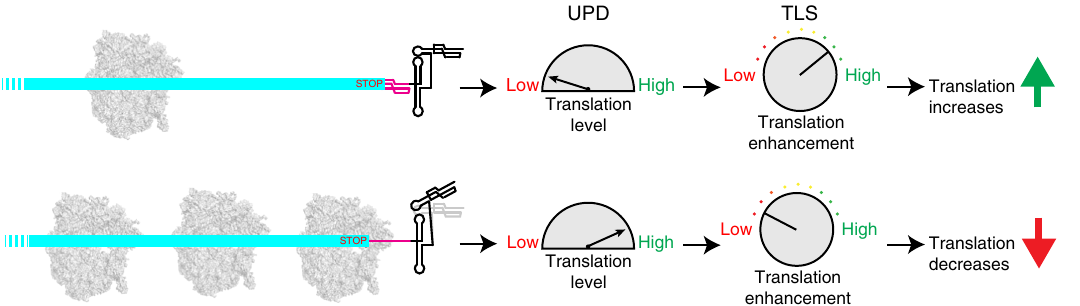
Fig. 8 A model for ribosome-induced programmed conformational changes. Schematic cartoon of the model of translation regulation on the sgRNA. With few translating ribosomes, the UPD sensor is mostly undisturbed, the TLS is stabilized, and translation is enhanced. When translation is high (many ribosomes), the UPD spends more time in an unfolded state, resulting in destabilization of the TLS structure and decreased translation